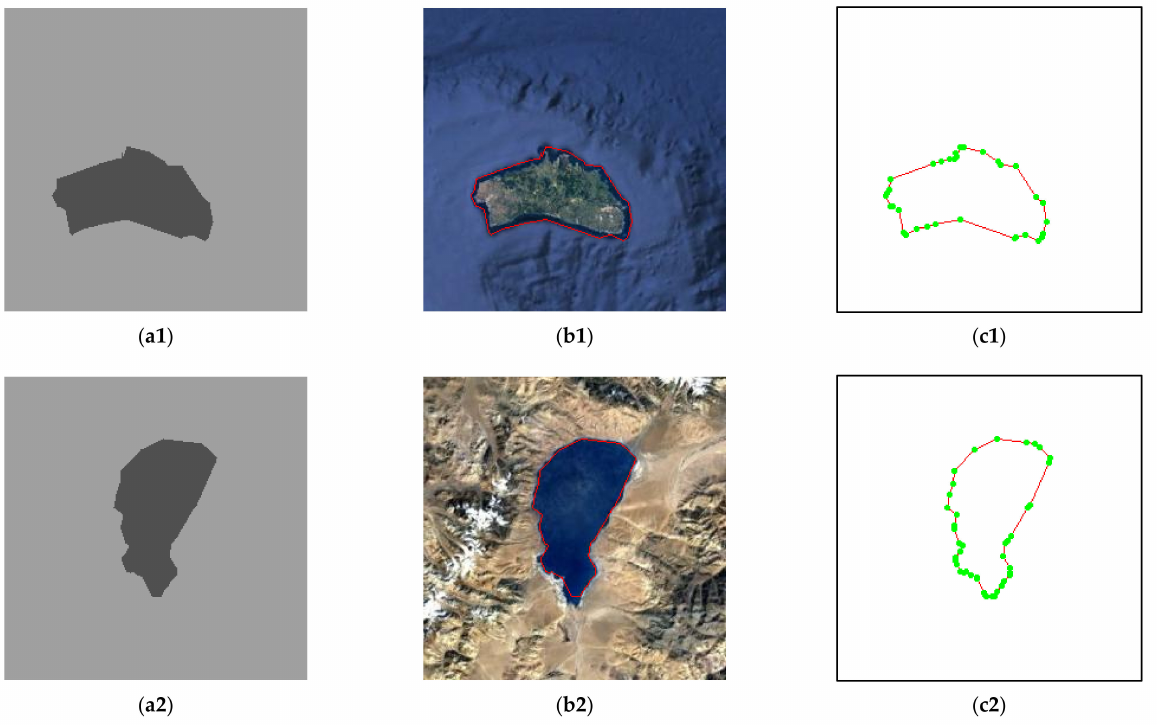
Figure 11. Island and lake extraction results: ( a1 ) Island segmentation results; ( b1 ) Contour overlay results; ( c1 ) Island extraction results; ( a2 ) Lake segmentation results; ( b2 ) Contour overlay results; ( c2 ) Lake extraction